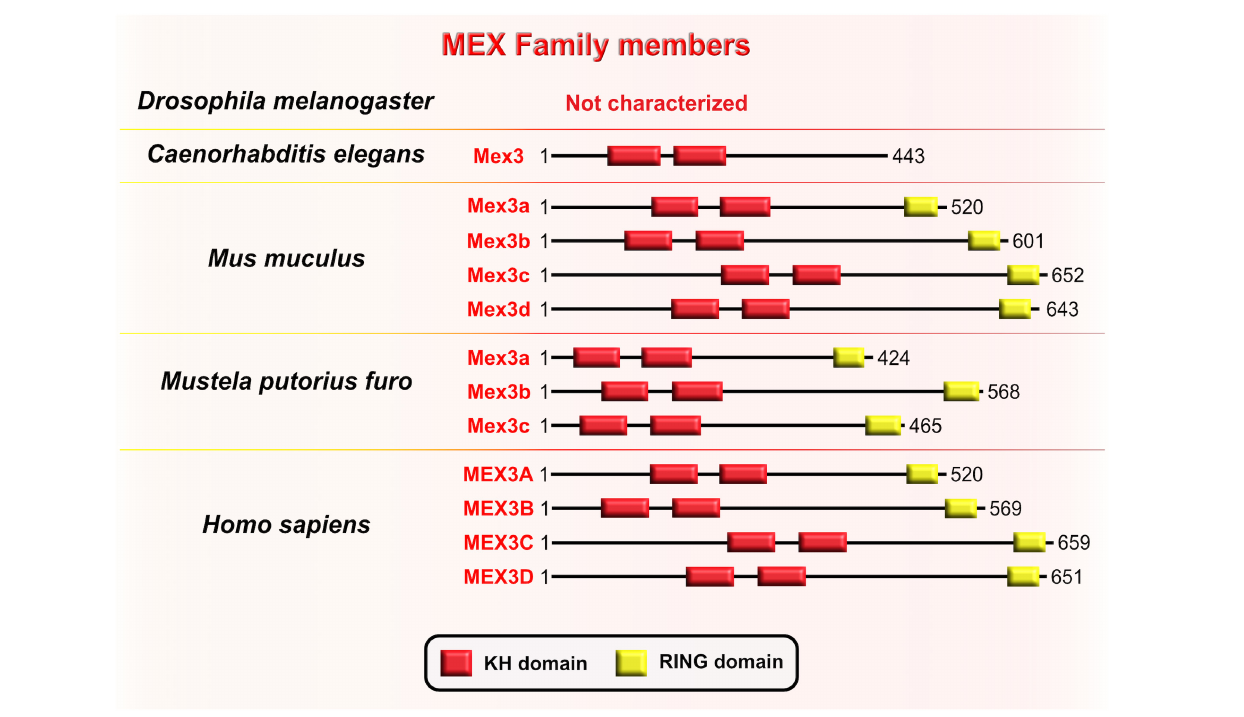
FIGURE 8 | Muscle excess 3 (Mex3) family of evolutionarily conserved RNA-binding proteins. Schematic presentation of binding domains K homology (KH) domain (red), and RING domain (yellow) in Mex3 family members in Drosophila melanogaster , Caenorhabditis elegans , Mus musculus , Mustela putorius furo , and Homo sapiens adopted by either UniProt database (https://www.uniprot.org) or NCBI (https://www.ncbi.nlm.nih.gov/). The UniProtKB of NCBI accession numbers are indicated below for members of Mex3 family in C. elegans : Mex3 (H2L067); M. musculus : Mex3a (NP_001025061.2), Mex3b (Q69Z36), Mex3c (Q05A36), Mex3d (Q3UE17); M. putorius furo : Mex3a (XP_012904401.1), Mex3b (XP_004763707.1), Mex3c (XP_012904006.1); and H. sapiens : MEX3A (A1L020), MEX3B (Q6ZN04) MEX3C (Q5U5Q3), MEX3D